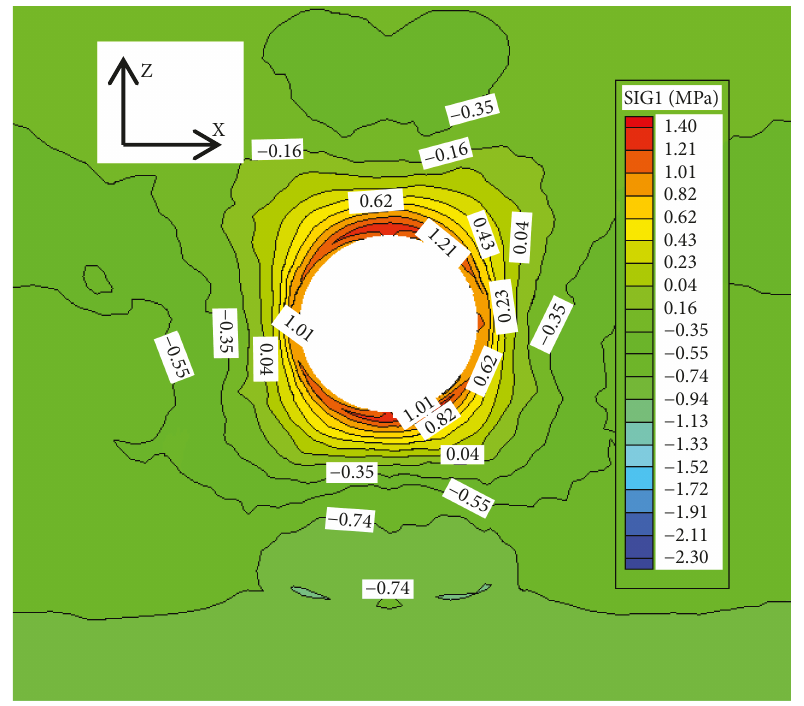
Figure 29: Major principal stress on section